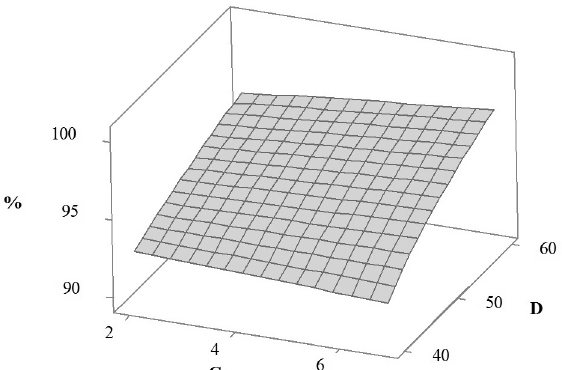
FIGURE 5 - Response surface plot of the effect of pH of dissolution media (C) and rotation speed (D) on the amount of acetaminophen dissolved